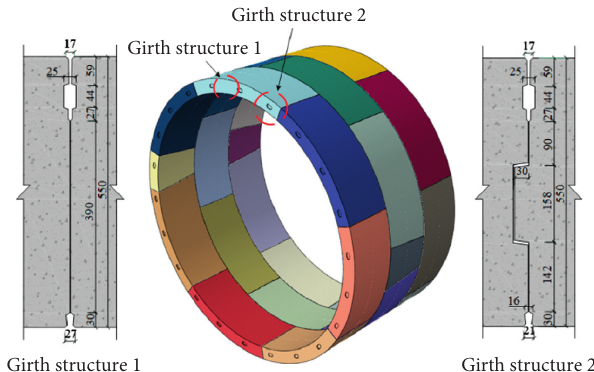
Figure 5: Detailed structure of circumferential